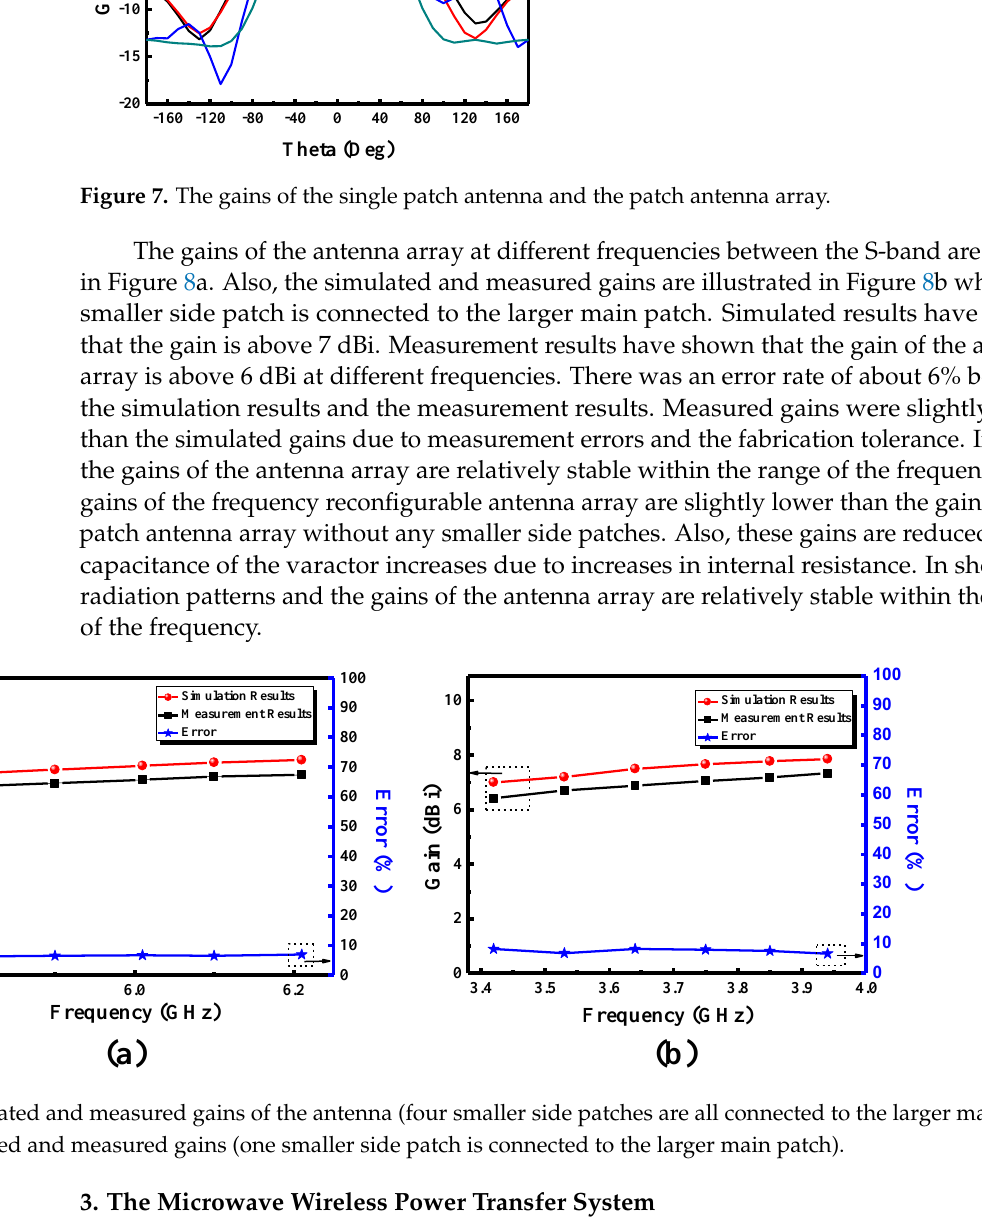
Figure 8. ( a ). Simulated and measured gains of the antenna (four smaller side patches are all connected to the larger main patch). ( b ). Simulated and measured gains (one smaller side patch is connected to the larger main patch).